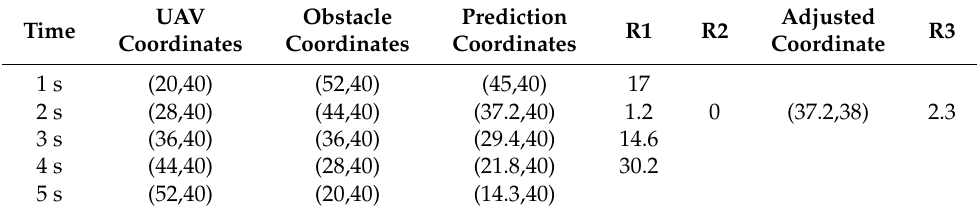
Table 8. Coordinate information of the local path adjustment in Figure 20a.